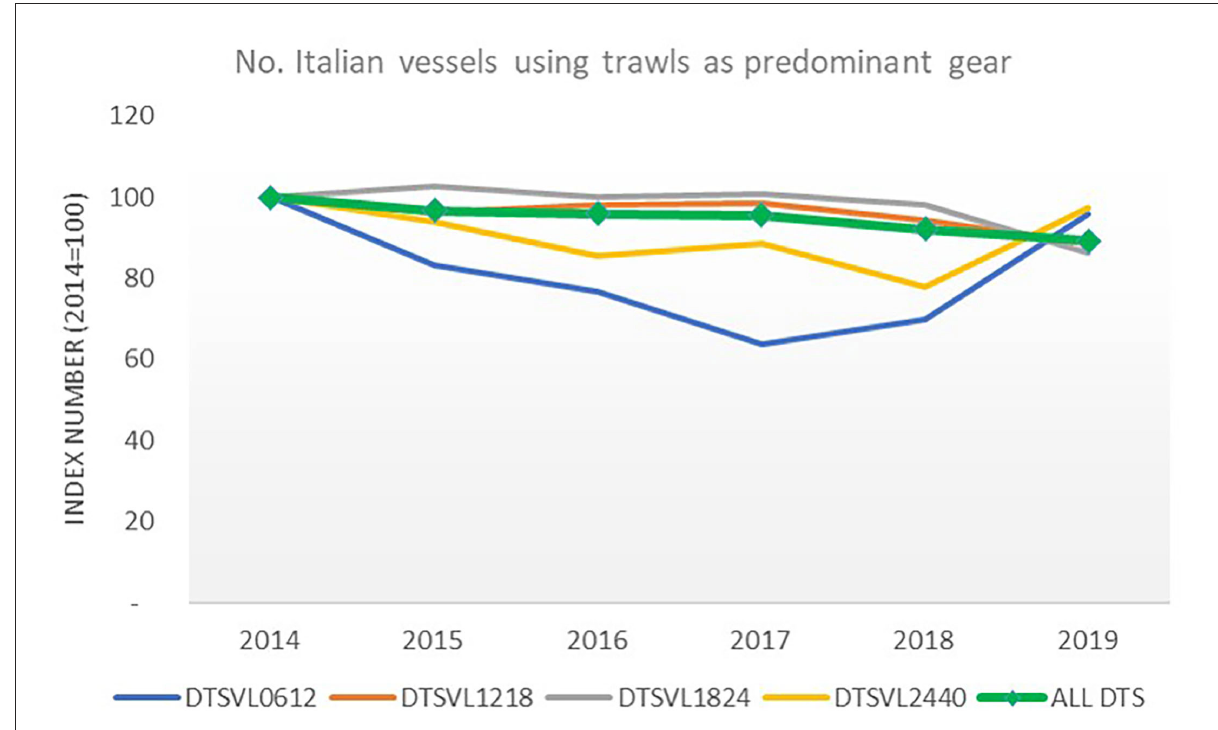
FIGURE6 Number of vessels using trawl nets as their predominant gear from 2014 to 2019 in Italy. Elaboration on data from STECF (2020-06) and STECF (20-10).